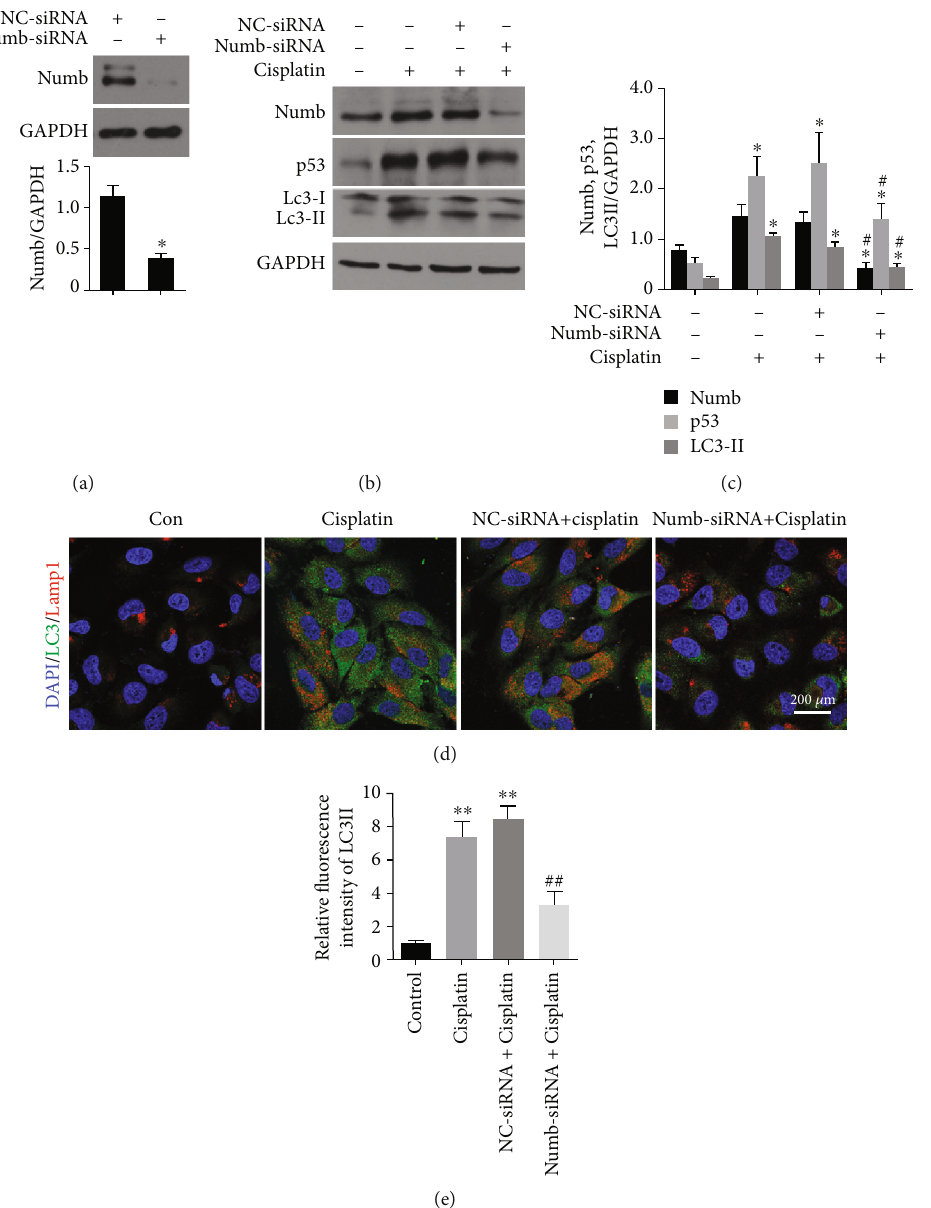
Figure 2: Silencing Numb inhibits Cisplatin-induced autophagy in NRK-52E cells. NRK-52E cells were transfected with scramble siRNA or Numb-siRNA followed by 20 μ M Cisplatin or vehicle (saline) for 6 hours. (a) The interference e ffi ciency of Numb was measured by Western blot assay. (b) The protein expression of Numb, p53, and LC3-II in cells of each group was detected by Western blotting; GAPDH was used as loading control. (c) Relative expression of Numb, p53, and LC3-II to GAPDH was represented in graphic. Data are shown with means ± SD, n =3. ∗ P < 0 : 05 versus cells treated with vehicle. # P < 0 : 05 versus scramble siRNA-transfected cells with Cisplatin treatment. (d) Representative immuno fl uorescence images of co-expression of LC3-II (green) and LAMP1 (red) in cells of di ff erent groups as indicated. Magni fi ed 600 times. (e) Quantitative statistics for immuno fl uorescence images. Data are shown as means ± SD, n =3. ∗∗ P < 0 : 01 versus Control group. ## P < 0 : 01 versus scramble siRNA-transfected cells with Cisplatin